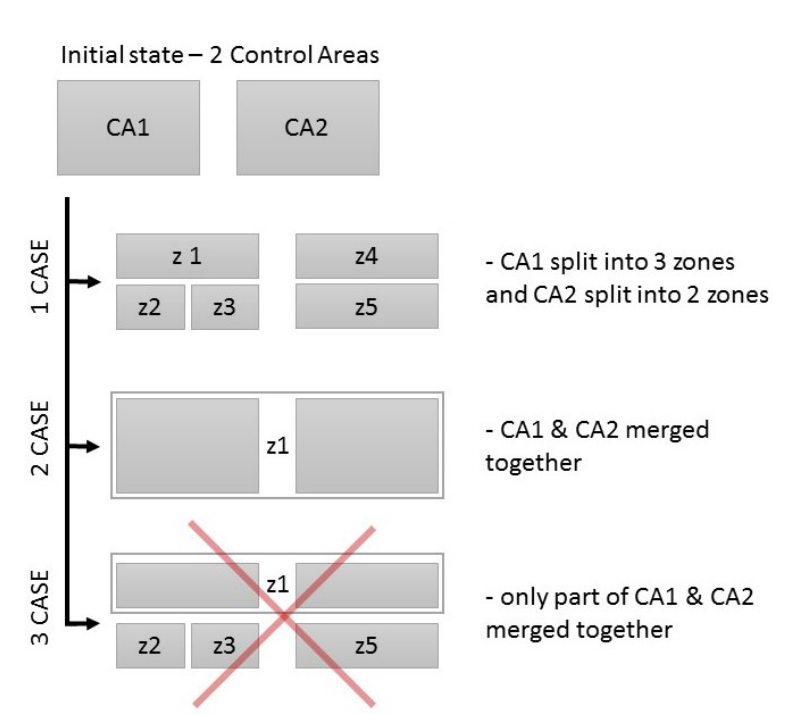
Figure 1. Allowed and forbidden bidding zones configurations with respect to control area